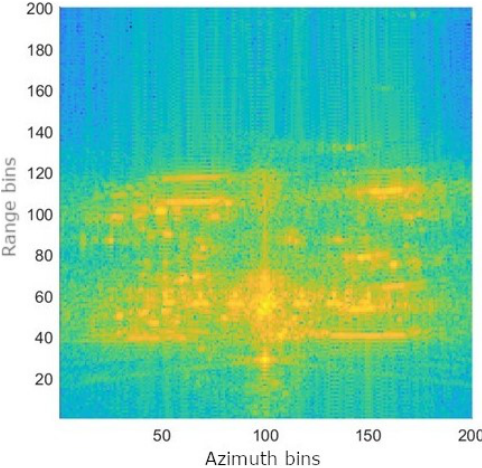
Figure 12. SAR image of Leopard tank using SARCASTIC